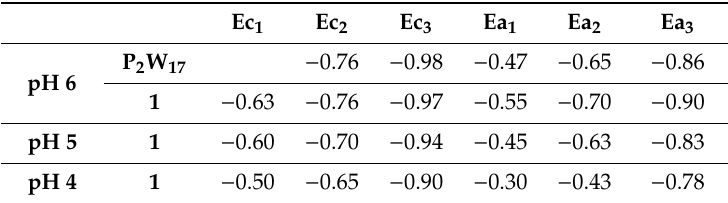
Table 2. Reduction, Ec, and oxidation, Ea, peak potentials (mV vs. SCE) measured from the CV of 1 and of P 2 W 17 recorded in the experimental conditions specified above.